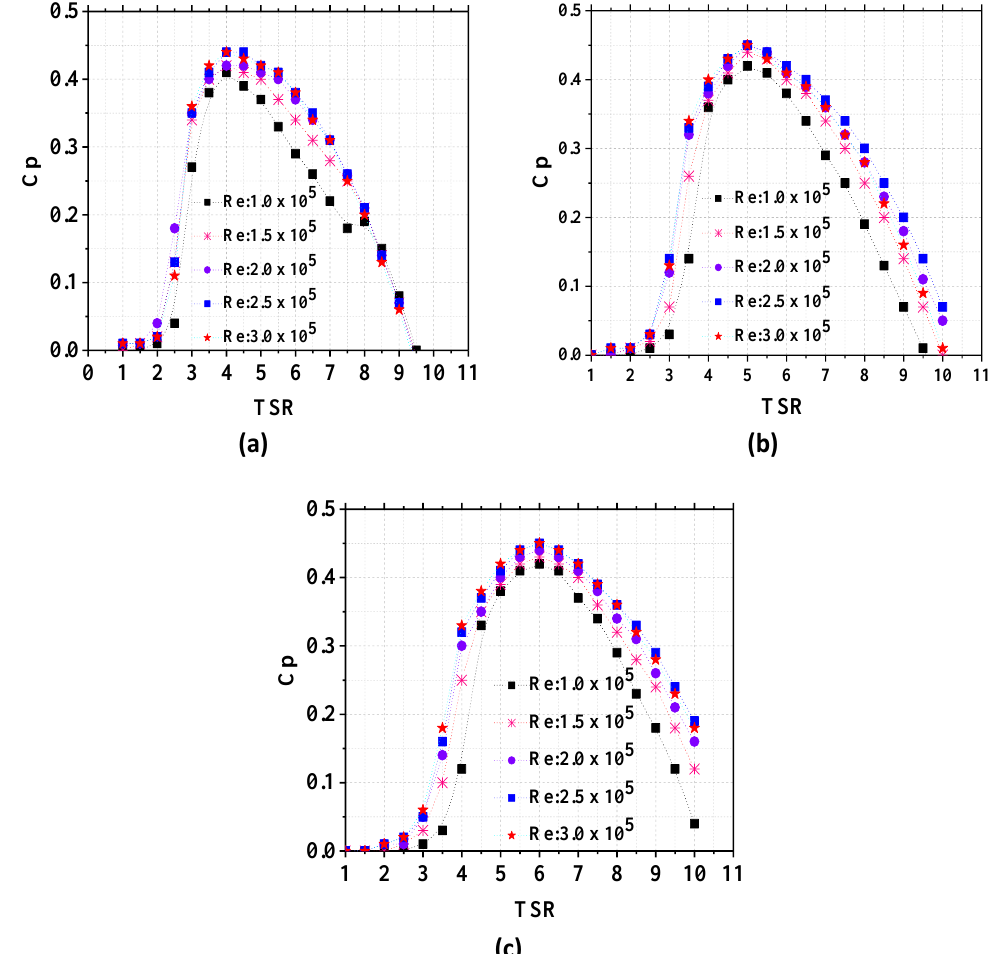
Figure 15. Power coefficients obtained with SG6043 rotor blades for ( a ) TSR 4 ( b ) TSR (5) ( c ) TSR 6.